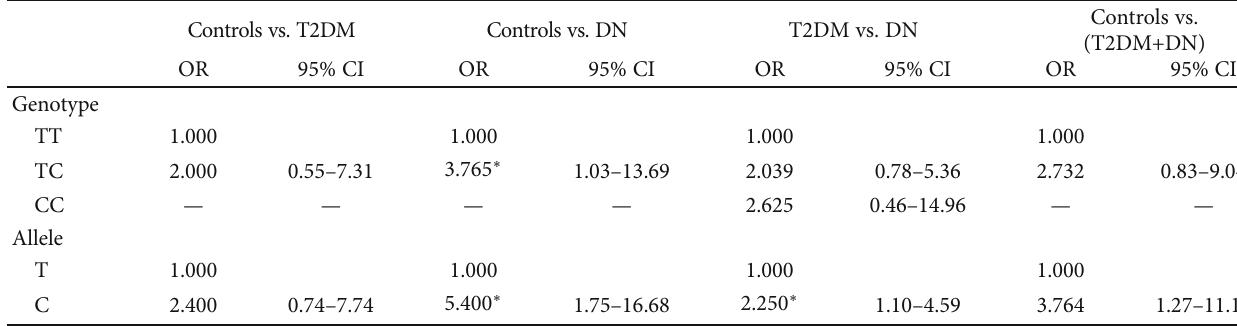
Table 4: Odds ratio of genotypes and alleles.